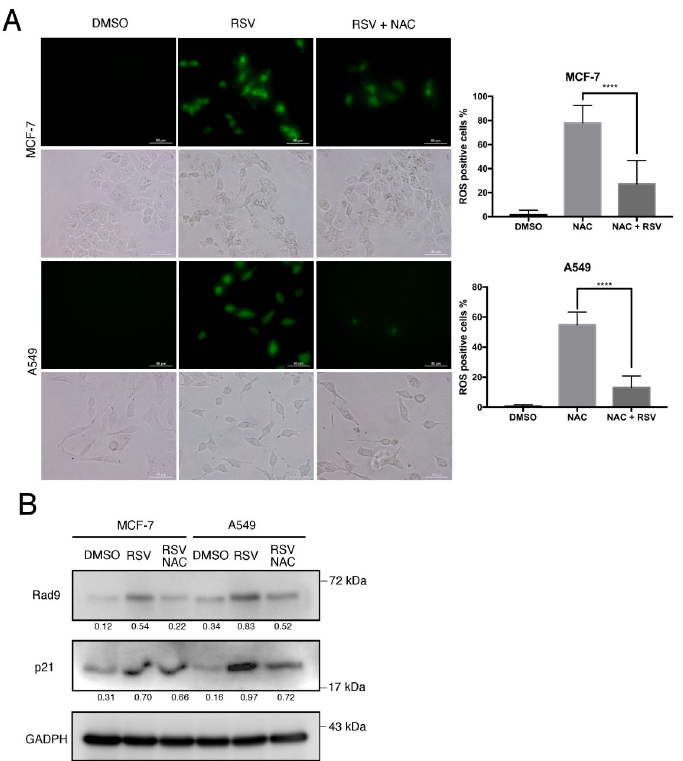
Fig 4. RSV induced Rad9 upregulation attenuated by NAC. (A) Green fluorescence of dichlorodihydrofluorescein (DCF) probe was used the quantitation of ROS in MCF-7 and A549 cells treated with RSV (25 μ M) with or without NAC (10 mM) for 24 h. Scale bar, 50 μ m, representative of three independent experiments. Data are means ± s.d., ���� P � 0.05. (B) MCF-7 and A549 cells were exposed to RSV with or without NAC (10 mM) for 24 h. The expression of Rad9 and p21 were determined by immunoblotting. Signals on the immunoblots were analyzed by ImageJ, normalized with that of